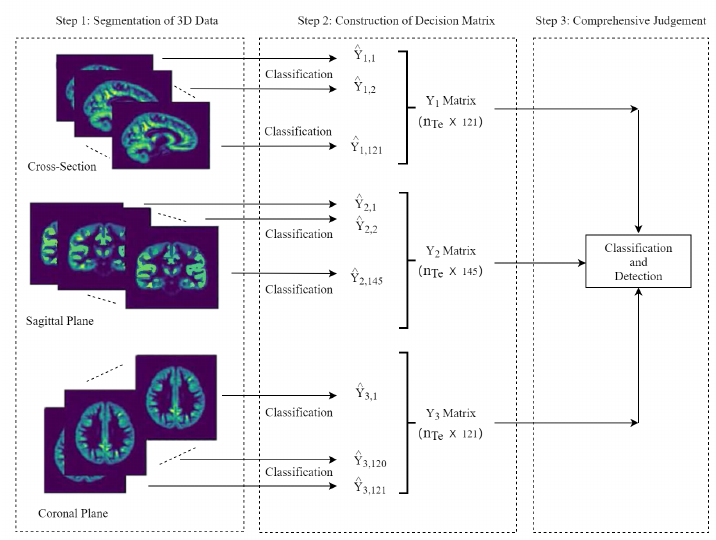
Figure 3. Flow chart of the proposed method on the testing